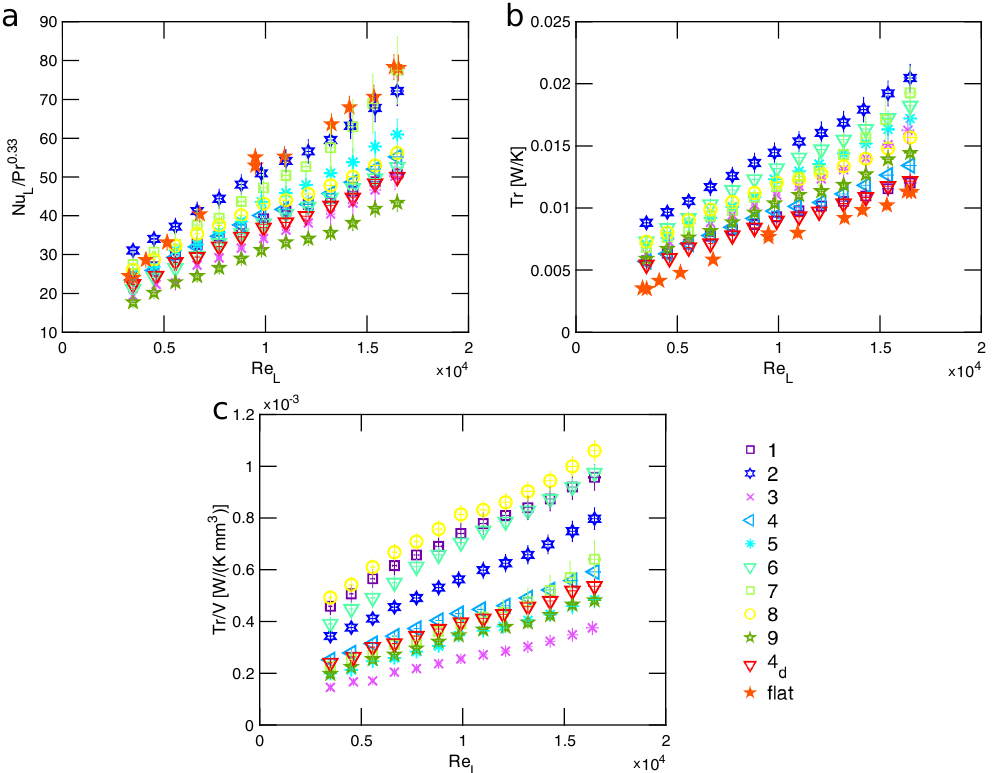
Figure 6. Experimental performance of heat sinks with ESR—shark-skin like—surface patterns at different Reynolds number: ( a ) Ratio between Nusselt and Prandtl numbers, Nu L / Pr 0.33 ; ( b ) thermal transmittance, Tr ; and ( c ) ratio between thermal transmittance and sample volume, Tr / V . In the legend, the number of each sample is associated with a symbol; “4d” indicates sample 4 tested in the downward direction with respect to the air flow one (all other points are obtained in the forward direction) and “flat” stands for the reference heat sink with a smooth